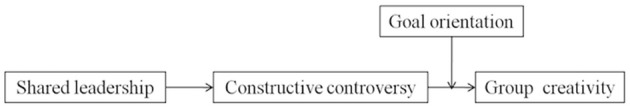
Hypothesized model.